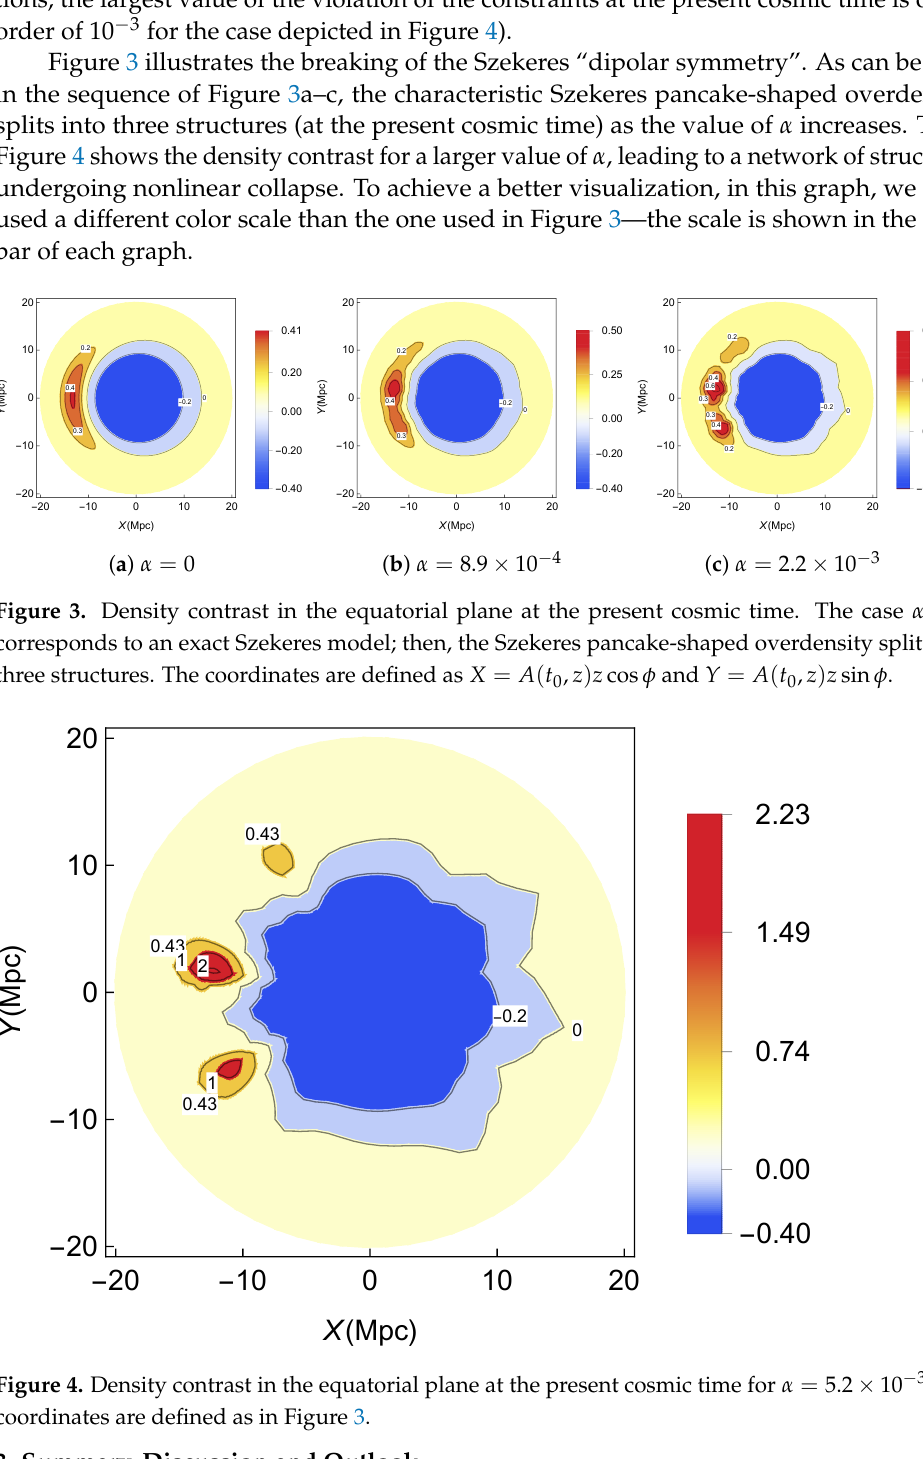
Figure 4. Density contrast in the equatorial plane at the present cosmic time for α = 5.2 × 10 − 3 . The coordinates are defined as in Figure